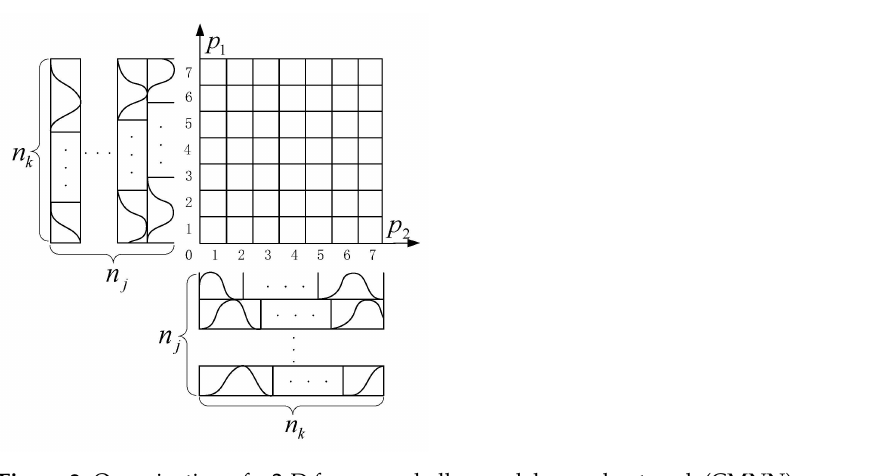
Figure 2. Organization of a 2-D fuzzy cerebellar model neural network